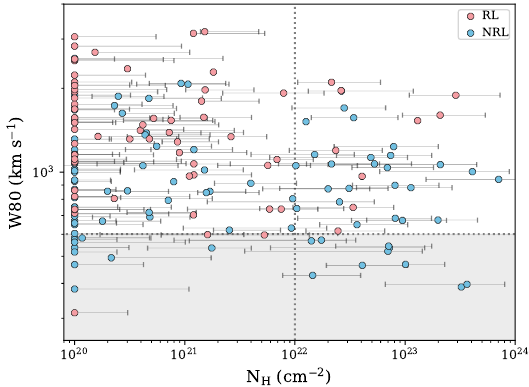
Figure 9. The [O III ] velocity width (W80) versus hydrogen column density (N H ). The vertical dotted line separates X-ray obscured (N H > 10 22 cm − 2 ) and unobscured (N H < 10 22 cm − 2 )